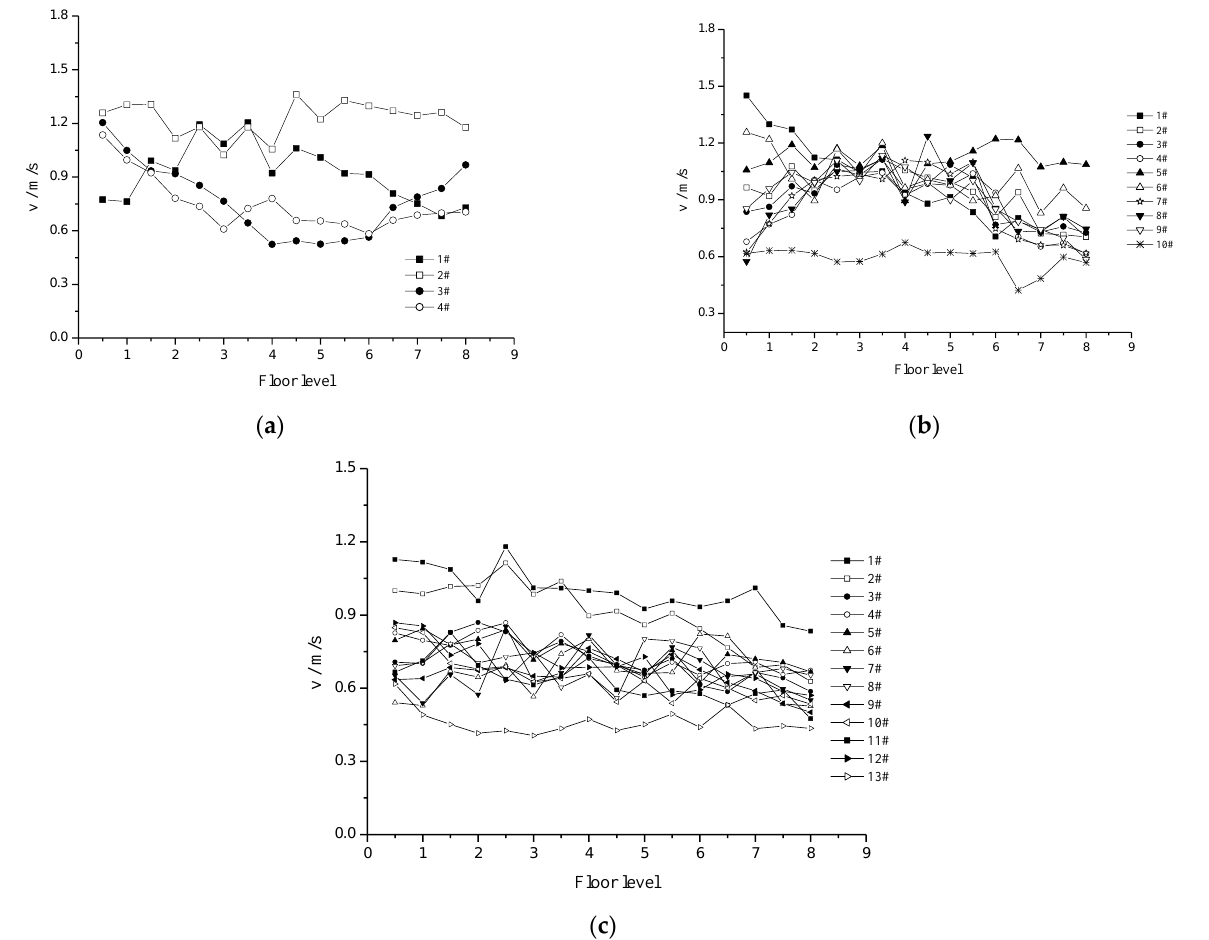
Figure 9. Ascending speed distributions of each participant in Group B along the climbing level (traveling over 8 floors). ( a ) Boys; ( b ) middle-aged male; ( c ) middle-aged female.